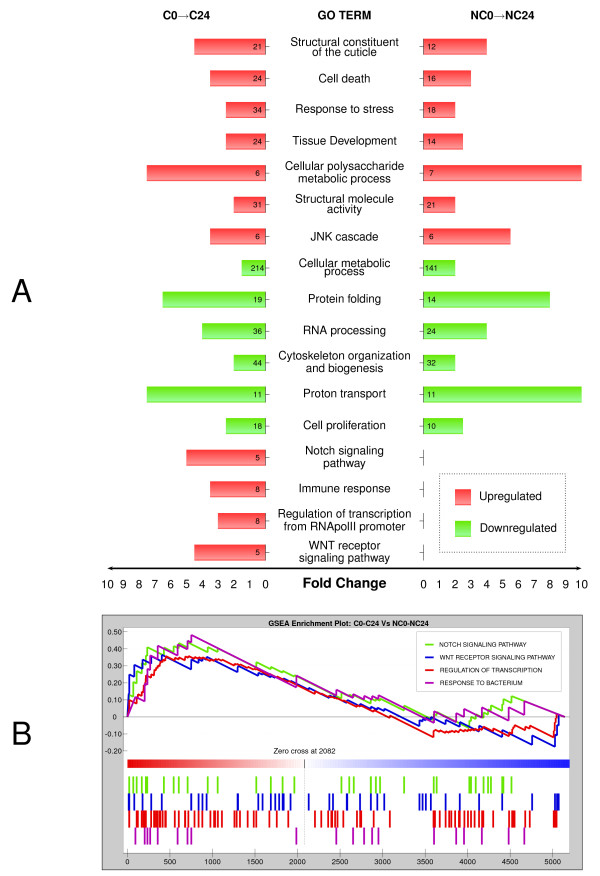
Whole genome expression analysis of cut (C) and uncut (NC) wing imaginal discs after 24 hours. (A) Gene ontology (GO) terms of upregulated (red) or downregulated (green) genes. The number of genes in each category in the microarrays is shown within the bars. The length of the bars indicates the fold change (enrichment in these transcriptomes compared to the whole genome, P value < 0.001 in all cases). (B) Enrichment plots for statistically significant GO categories. (Top) The Enrichment Score (ES) computed by GSEA is shown for each category. ES value reaches its absolute peak on the left side of the enrichment plot, indicating overrepresentation in C0→C24 compared with NC0→NC24. The zero cross mark indicates the point in which the difference between expression in C0→C24 and NC0→NC24 is 0. (Bottom) Coloured bars illustrate the position of genes belonging to each GO category ranked according to their expression values in C and NC discs.